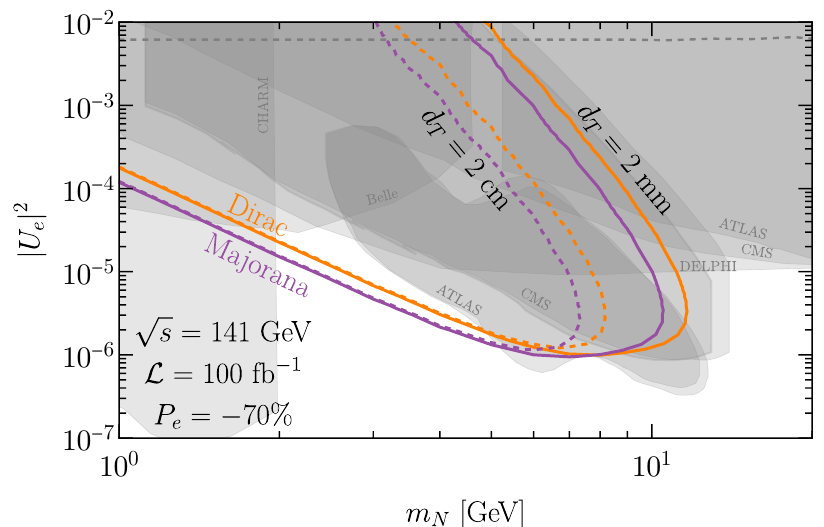
Figure 11 . The expected contours of N = 5 displaced vertex events detected in the EIC detector. The Majorana (Dirac) type events are shown as purple (orange) lines. The solid (dashes) lines indicate the impact parameter choice as d T = 2 (20) mm. These results are compared with the existing bounds from direct searches [74–80] (gray shaded regions) and indirect precision electroweak constraints [81] (horizontal dashed line). In particular, we include existing displaced vertex searches in the 13 TeV CMS [78] and ATLAS [80] experiments (dark-shaded islands), for both Majorana and Dirac HNLs, which are very closer to each